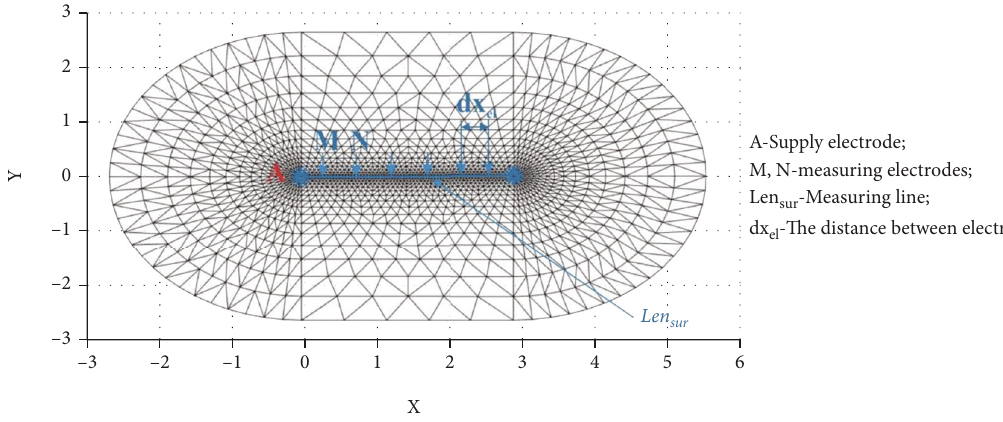
Figure 2: Computational mesh for simulating the electric fi eld by IEM on the ground surface (top view on XY plane).